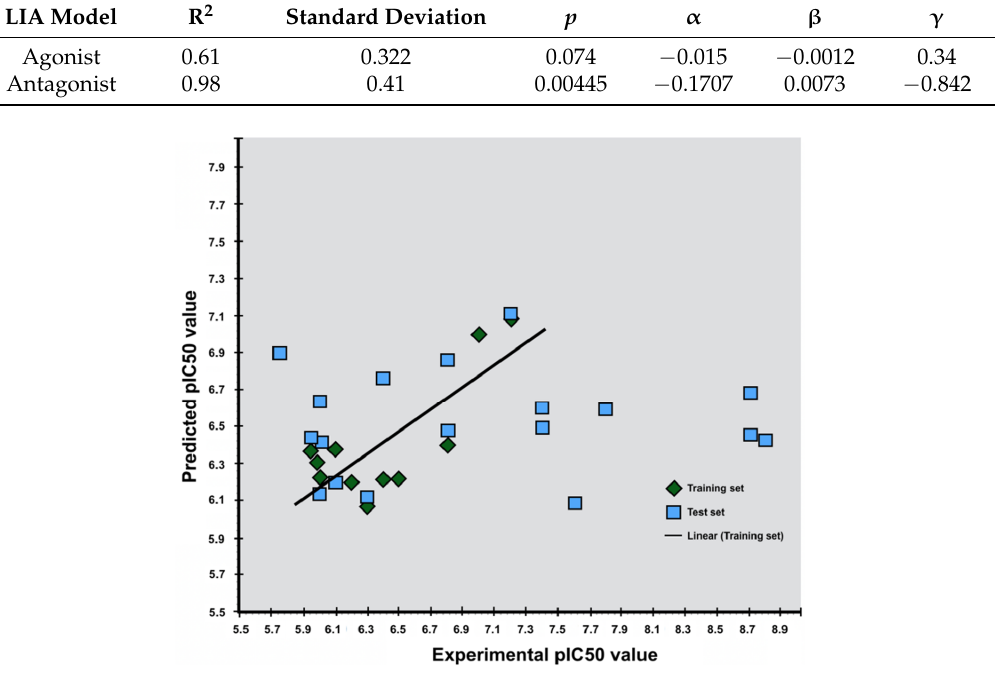
Figure 4. Cont. Figure 4.